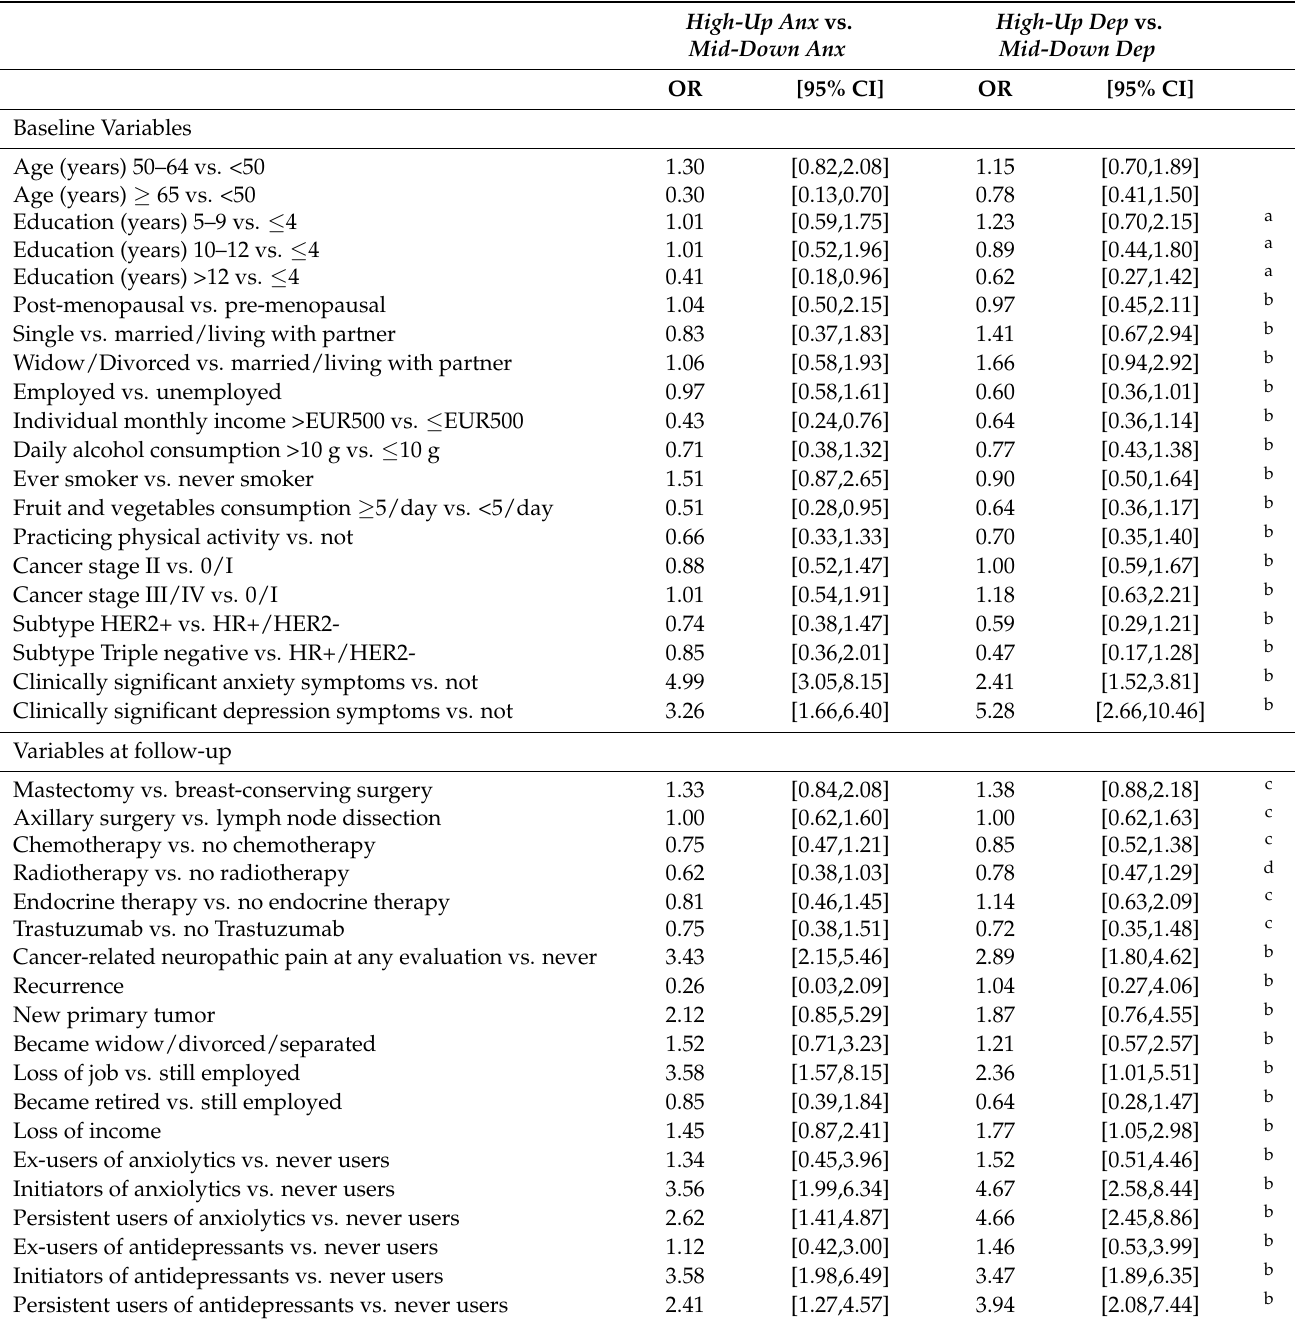
Table 2. Associations between baseline and follow-up variables with High-up Anx vs. Mid-down Anx trajectory and with High-up Dep vs. Mid-down Dep trajectory. High-Up Anx vs. High-Up Dep Mid-Down Anx